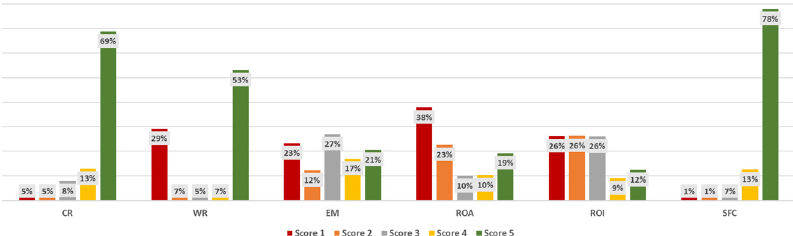
Figure 3: Percentage distribution by score, Year